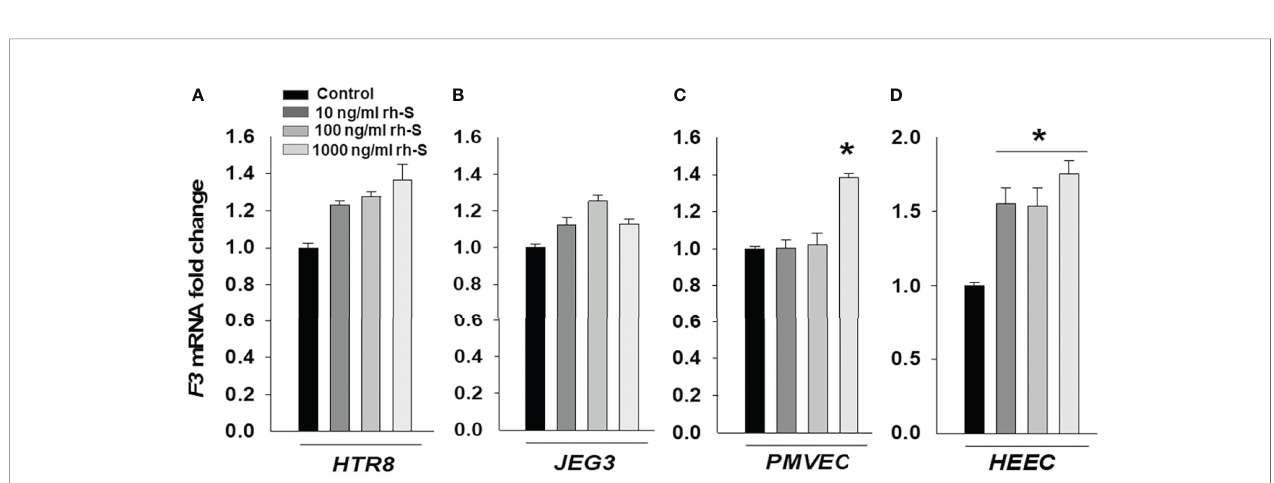
FIGURE 4 | Increased tissue factor mRNA levels by rh-S-protein in endothelial cell, but not in trophoblast cell cultures. qPCR analysis measured tissue factor ( F3) mRNA expression in trophoblast cell lines HTR8/SV Neo (A) and JEG3 (B) as well as endothelial PMVEC (C) and HEEC (D) cultures treated with mock-treated control or 10, 100, or 1000 ng/ml rh-S-protein. Bars represent mean ± SEM, n=3; * P<0.05 vs. control, 10 or 100 ng/ml rh-S-protein in PMVECs; and * P<0.05 vs. control in HEECs.